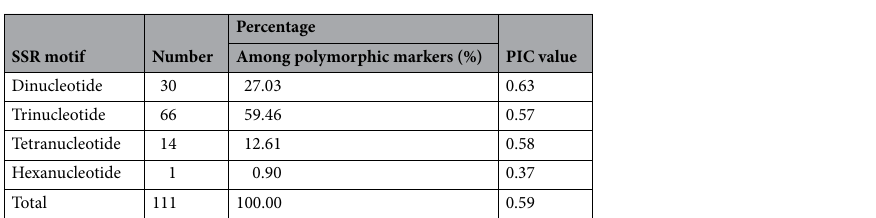
Figure 2. PAGE results of marker detection and population analysis. ( a ) Marker detection in 10 C. japonica accessions. ( b ) Population analysis in 89 accessions across genus Camellia . CjSSR094, CjSSR021, CjSSR128 and CjSSR166 were chosen from SSR markers with di-, tri-, tetra-, and hexanucleotide repeat, respectively.